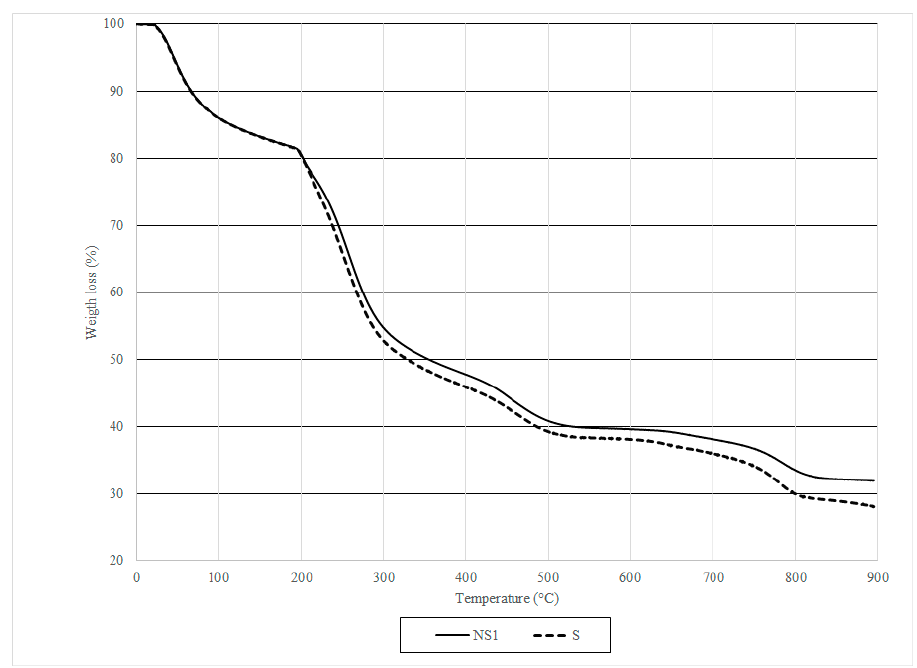
Figure 10. Thermogravimetric analysis (TGA) results of NS1 and Scapsules after 7 days in CF. Solid line: NS1 capsules, dashed line: S capsules.